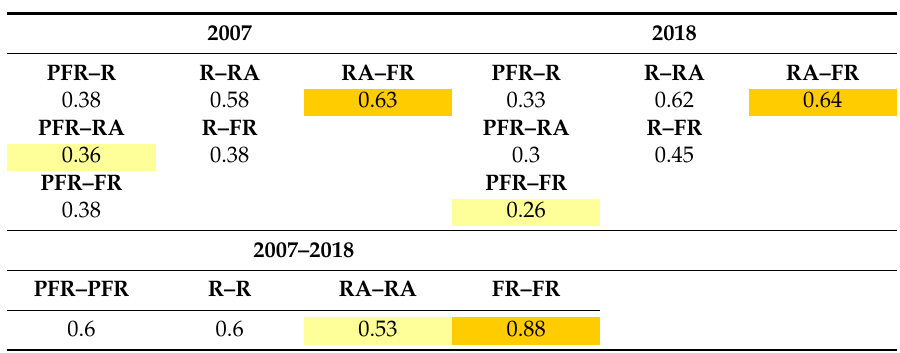
Table 9. The Jaccard’s species similarity coefficient values for macrophytes for sectors of the littoral of Lake Piaseczno in 2007 and 2018 (extreme values are marked with colours: yellow, min; orange,